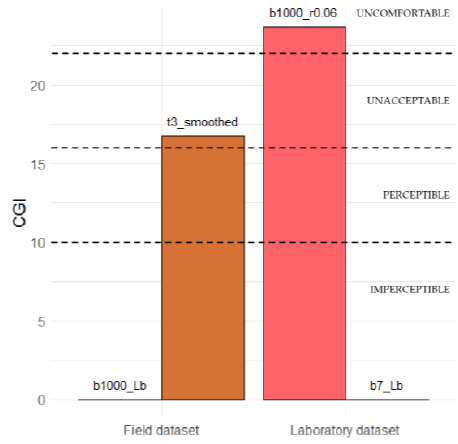
Figure 41. Commission on Illumination Glare Index (CGI) of the same visual scene for different evalglare methods and parameters (field and laboratory studies).